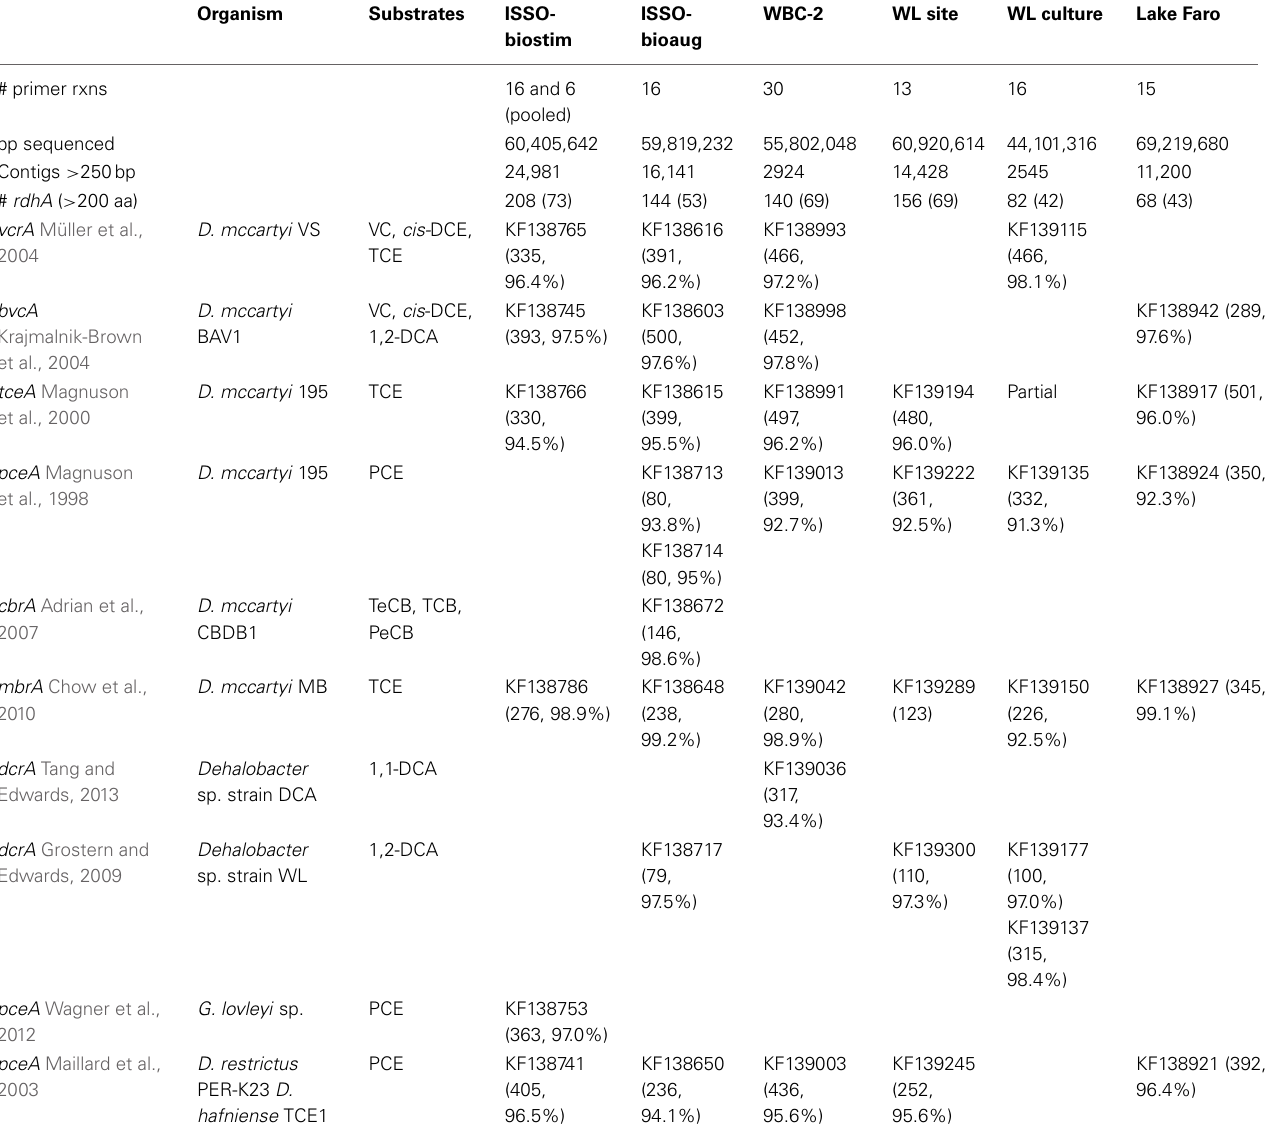
Table 2 | Summary statistics for sequence assemblies and distribution of homologs to substrate-characterized reductive dehalogenases in each